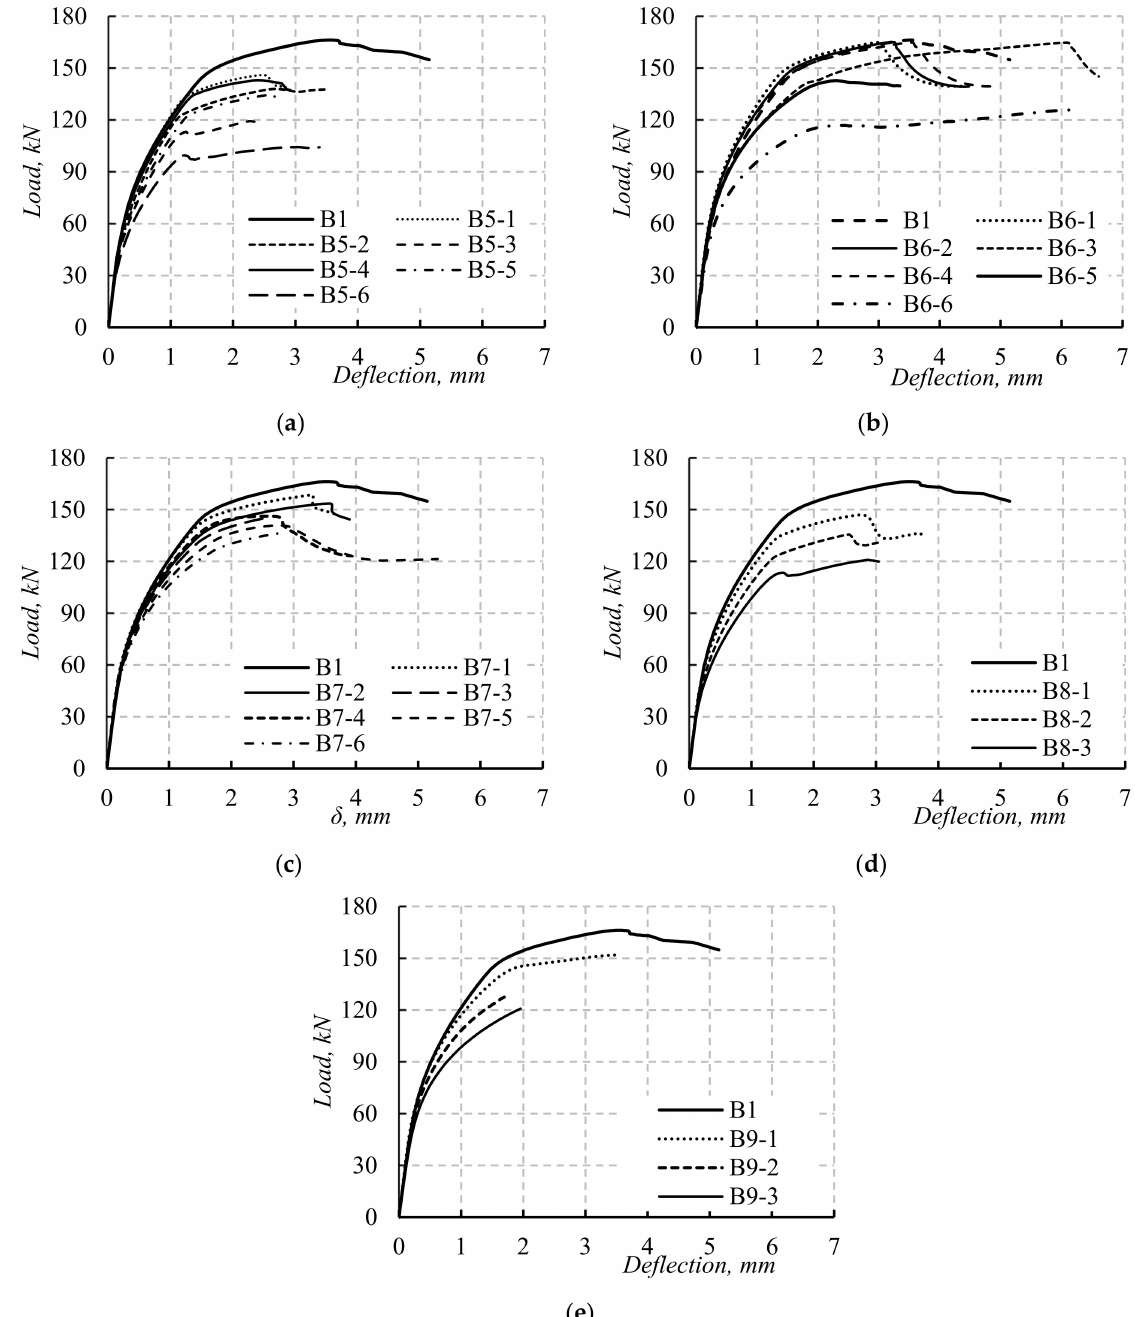
Figure 13. The P – δ curves of the simulated beams with L = 1100 mm: ( a ) beams with TNCH; ( b ) beams with TNSH; ( c ) beams with LH; ( d ) beams with LH and TNCH; ( e ) beams with LH and